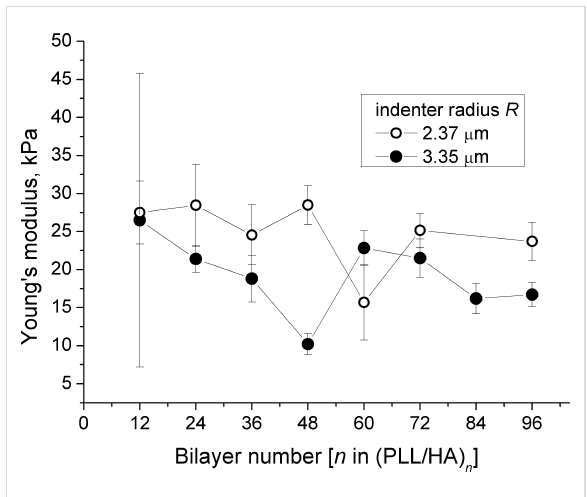
Figure 7: Young’s modulus E as a function of (PLL/HA) n bilayer number n for an indenter radius of 2.37 μ m (open circles) and 3.35 μ m (closed circles). Neither n nor R seem to affect the calculated E in a systematic way at an indentation velocity of 400 nm/s.